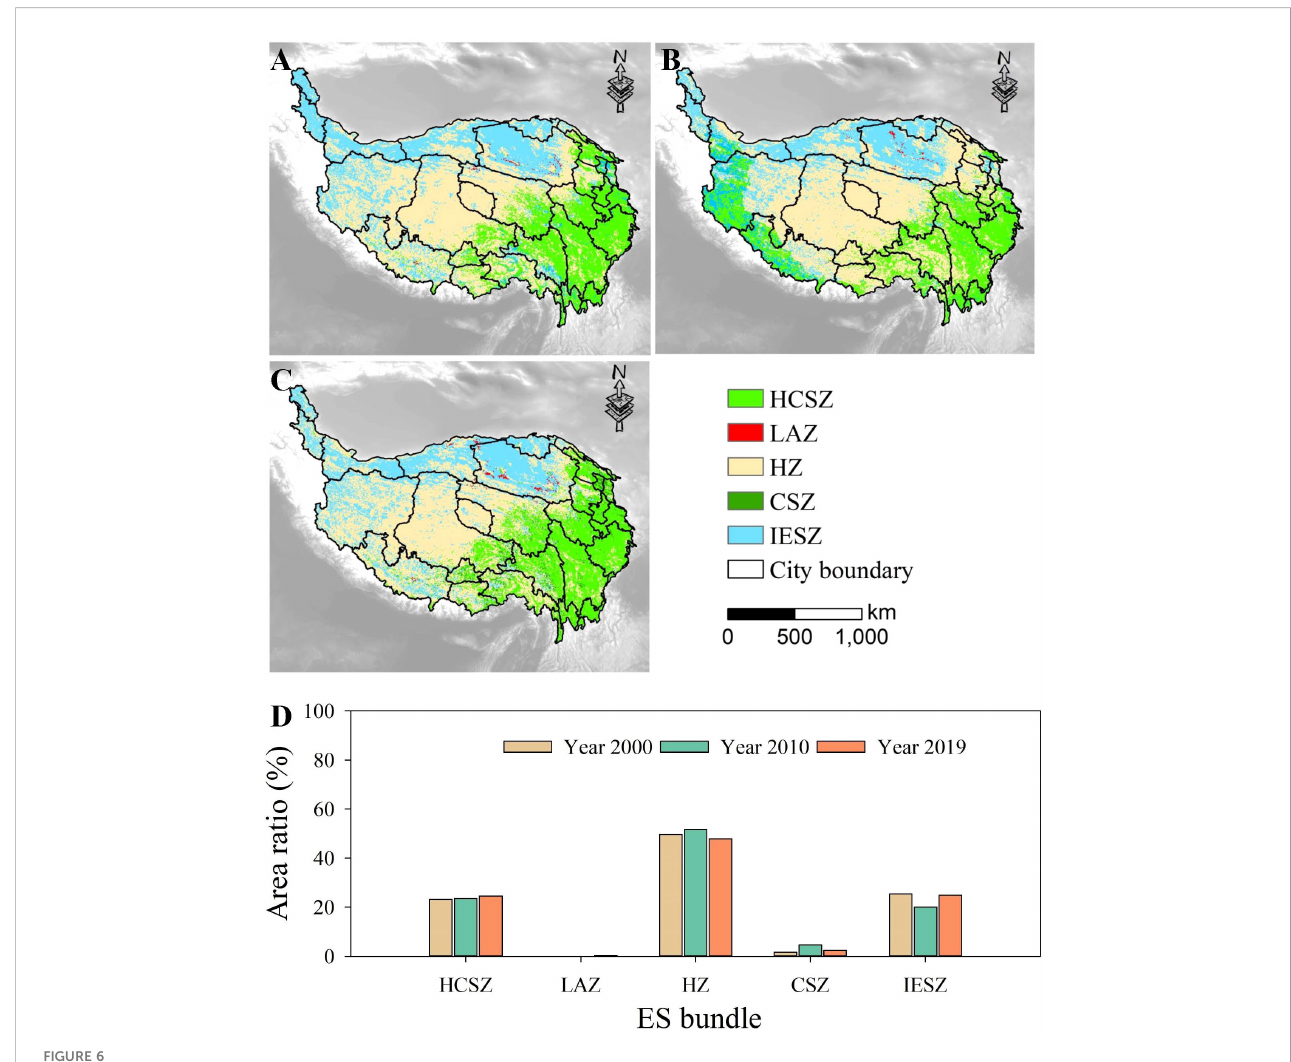
FIGURE 6 ES bundles in 2000 (A) , 2010 (B) , and 2019 (C) and dynamics over time (D)